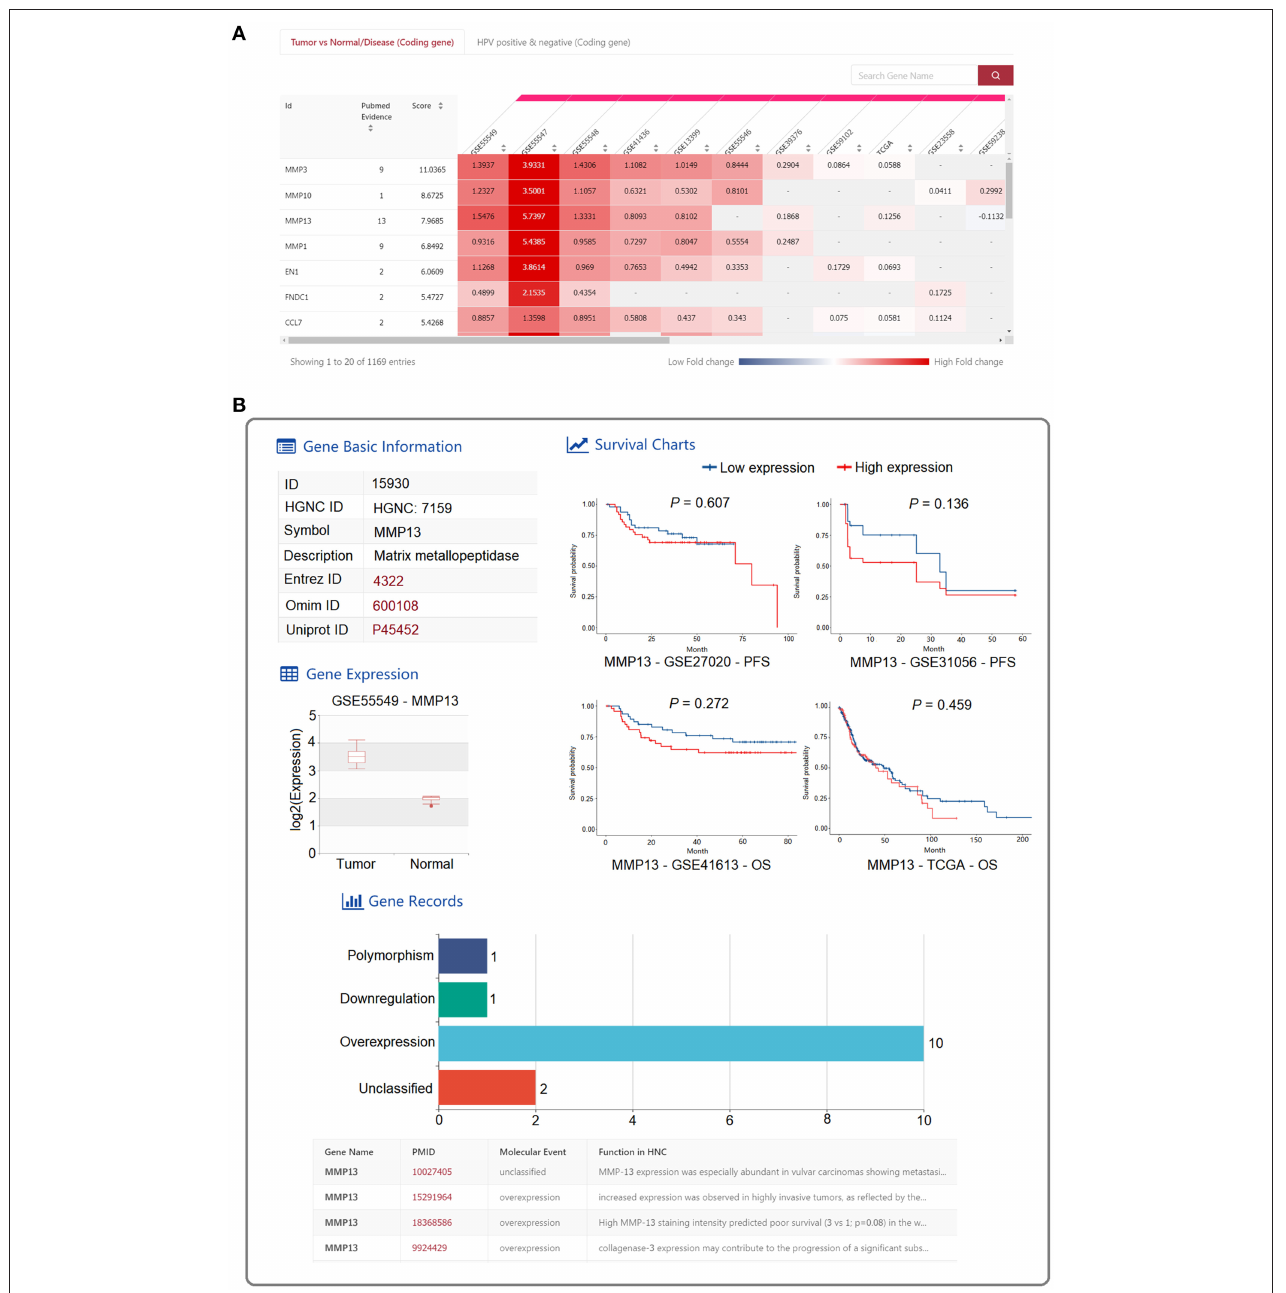
FIGURE 2 | Web interface for “HNC GENE” in HNCDB. (A) An interactive heatmap displaying the differential expression results of the 1,173 HNC-related genes across all the HNC gene expression datasets. (B) Detailed information of a selected gene in a certain